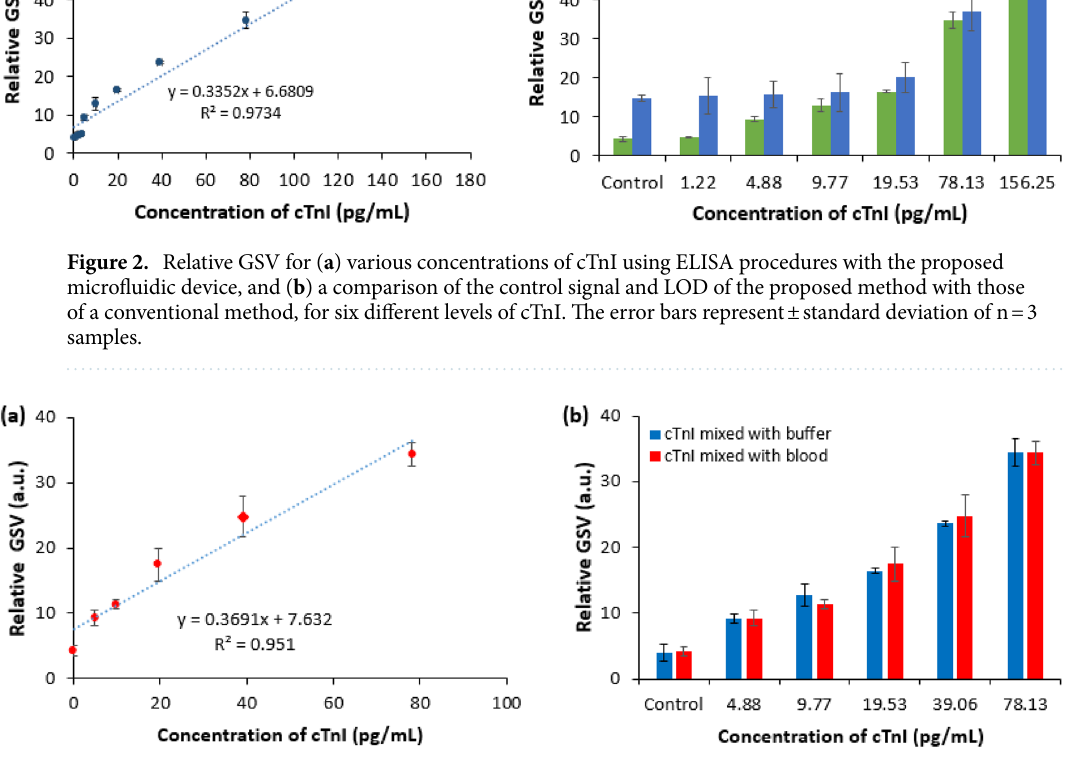
Figure 3. ( a ) Relative GSV for different concentrations of cTnI in blood with the developed device, and ( b ) comparative post-assayed relative GSV using the proposed ELISA device for different concentrations of cTnI mixed with buffer and diluted blood. The error bars represent ± standard deviation of n = 3